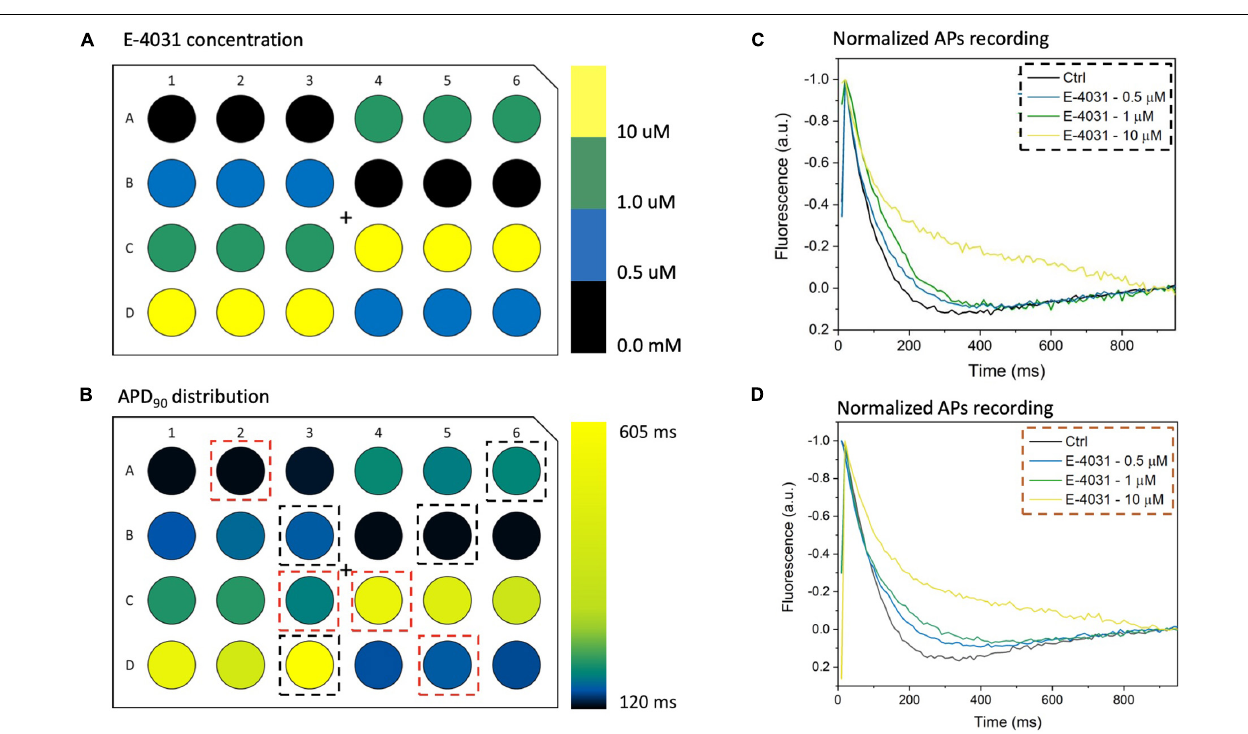
FIGURE 8 | MULTIPLE detection of AP duration with E-4031. (A) E-4031, a selective Kv11.1 channel blocker, was applied at 7 different concentrations ranging from 0 to 10 µ M to CheRiff-expressing HL-1 cells in a 24-well plate with each dose given to six wells distributed across the whole plate. (B) Resulting APD 90 values were quantified, which attested that interwell variability was not a critical issue since similar values were registered from wells with cells exposed to the same E-4031 concentration. (C,D) Average AP traces of CheRiff-expressing HL-1 cells from 10 optical recordings (1 Hz stimulation frequency). For comparison datasets (two for each concentration) were taken from wells randomly positioned. AP duration increased in a drug dose-dependent manner, with clear APD prolongation at E-4031 concentrations higher than 1 µ